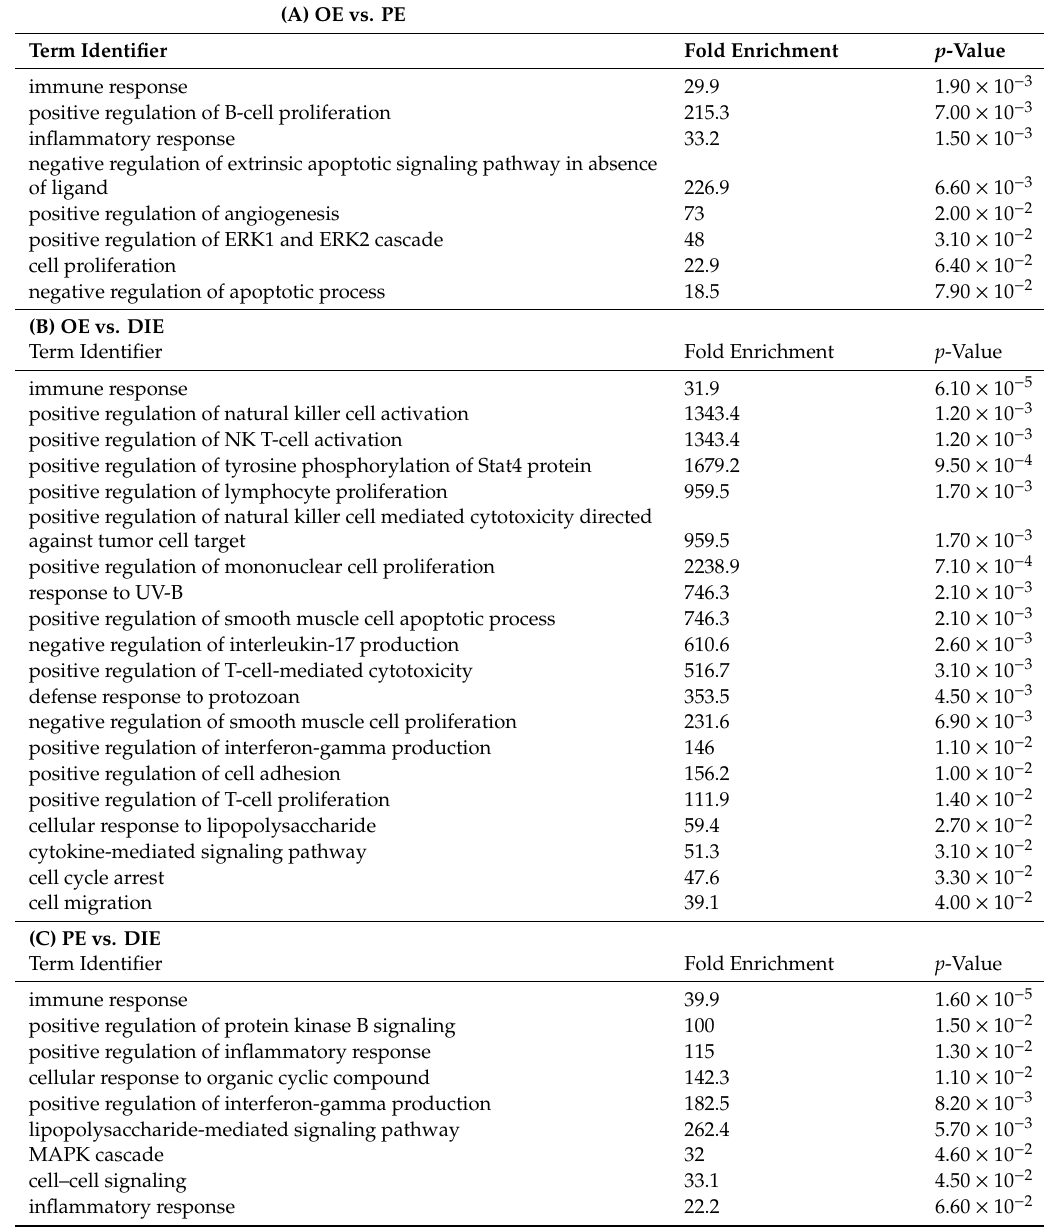
Table 2. Functional enrichment analysis of endometriosis subphenotype cytokine